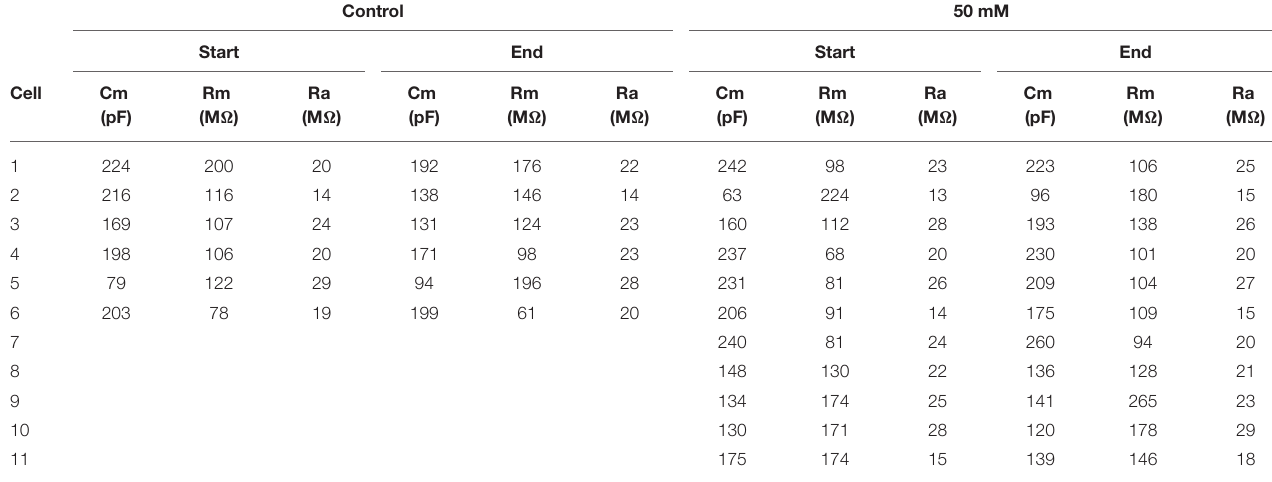
TABLE 4 | Membrane properties for experiment shown in Figure 5